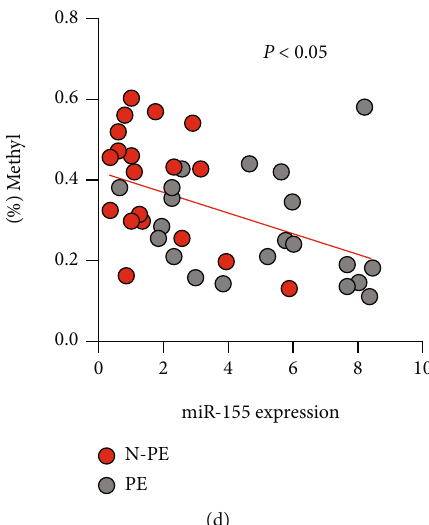
Figure 1: In fl ammatory response and upregulated miR-155 expression are observed in PE patients. (a) IL-6, IL-8, and TNF- α in the serum derived from 20 cases of PE and 20 cases of non-PE samples were detected using enzyme-linked immuno-sorbent assay. (b) miR-155 expression in the placental tissues of PE patients or normal placental tissues determined by RT-qPCR ( n = 20 ). (c) A schematic drawing shows CpG sites in the miR-155 gene promoter and BSP assay location. Each vertical bar represents a CpG site (12 sites). (d) miR-155 expression was inversely correlated with its promoter methylation level in 20 cases of PE and 20 age-matched non-PE samples. ∗ P < 0 : 05 , and ∗∗ P < 0 : 01